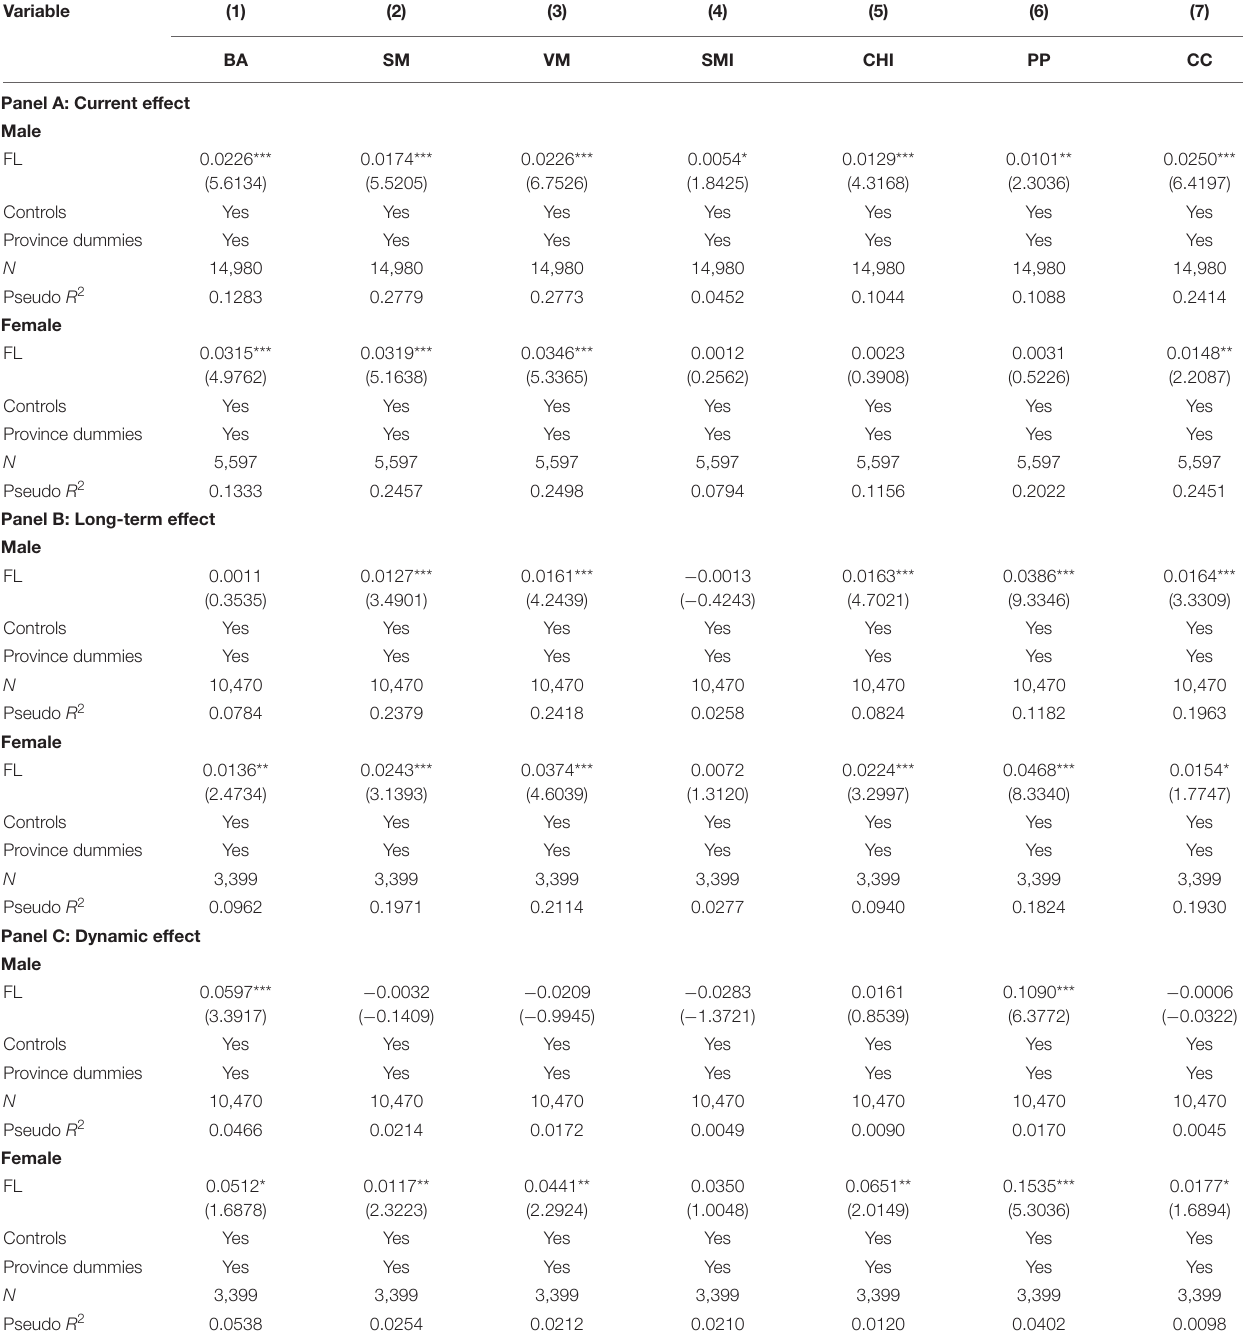
TABLE 16 | Gender heterogeneity